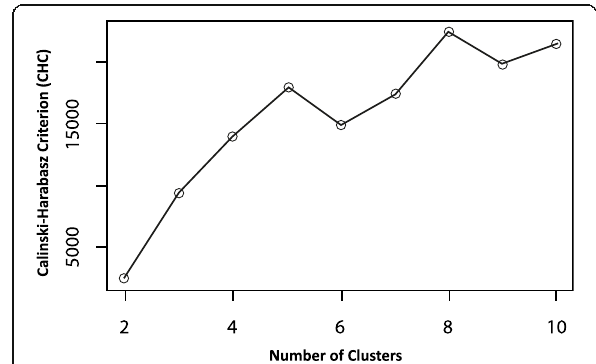
Fig. 6 Calinsky-Harabasz criterion for different number of clusters in the